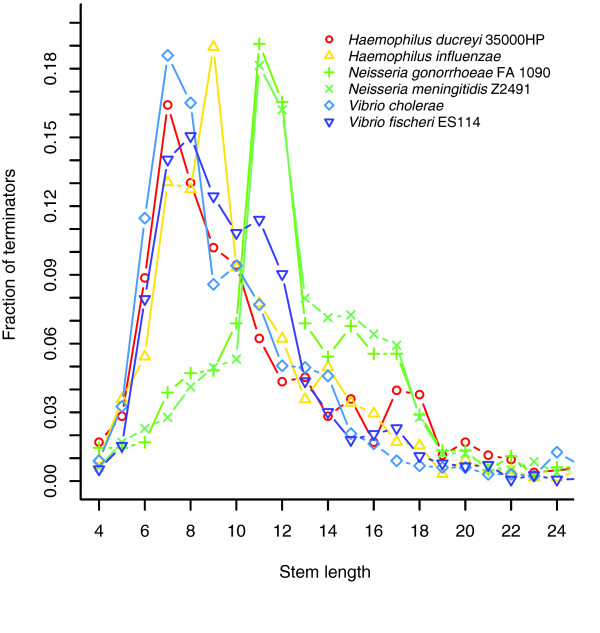
Stem lengths for high-confidence terminators in six organisms. These six organisms exhibit quite different distributions of stem lengths, with Neisseria having, on average, the longest stems, and the H. ducreyi and V. cholerae having the shortest. Because the statistics are computed using only high-confidence terminators, they may be skewed toward longer stem lengths.